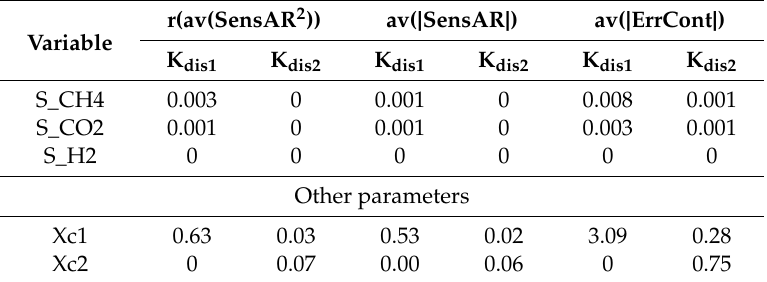
Table A4. Variables ranked based on sensitivity to K dis1 and K dis2 in the bulk reactor